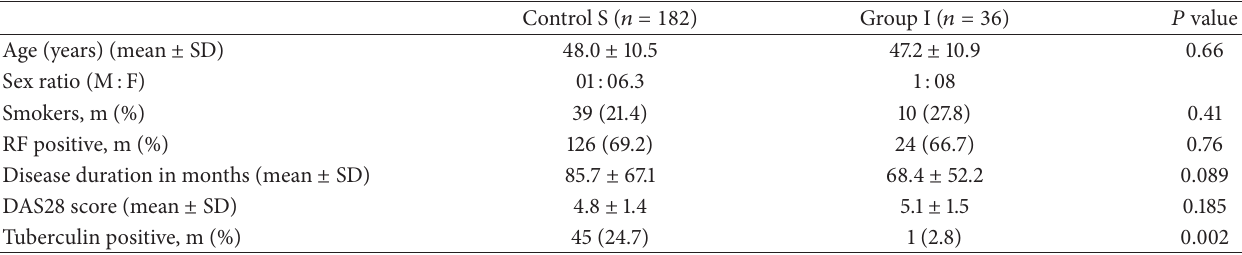
Table 2: Demographic profile of patients grouped according to steroid intake. Control S ( 𝑛 = 182 ) Group I ( 𝑛 = 36 ) 𝑃 value